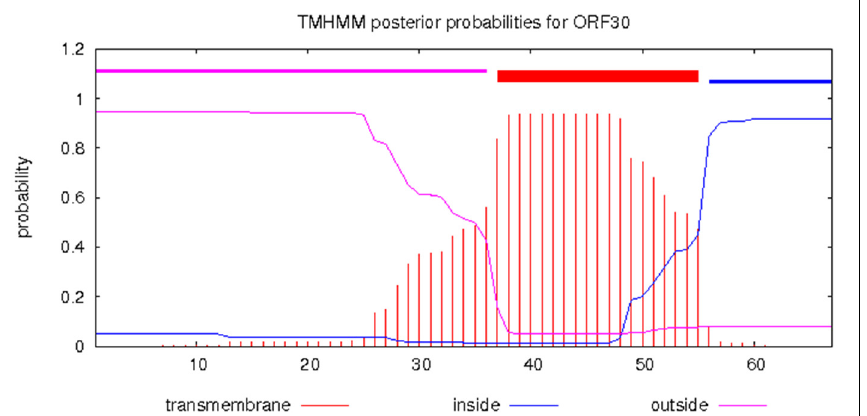
Figure 7. Predicted holin class II ( gp 30, GenBank No. QSJ04750) transmembrane structure using the TMHMM prediction server. Red blocks are predicted transmembrane domains on the top line, while the abscissa represents the sequence position, and the ordinate represents the prediction probability.